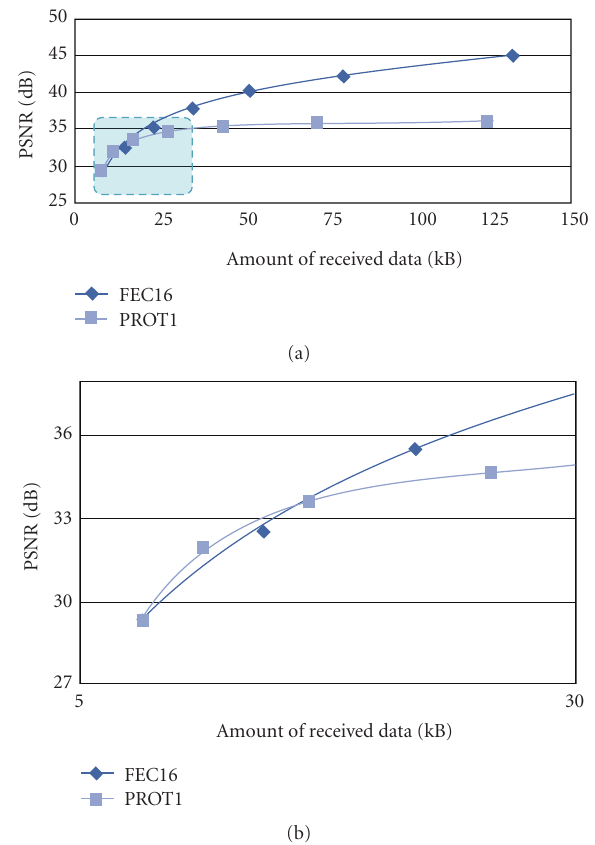
Figure 24: (a) Rendering distortion as a function of the amount of transmitted data (10% packet loss, warping to viewpoint v3); (b) Enlarged image of the highlighted region. Table 1: Redundancy allocation for texture information ( R = 8). Quality layer Data Red.